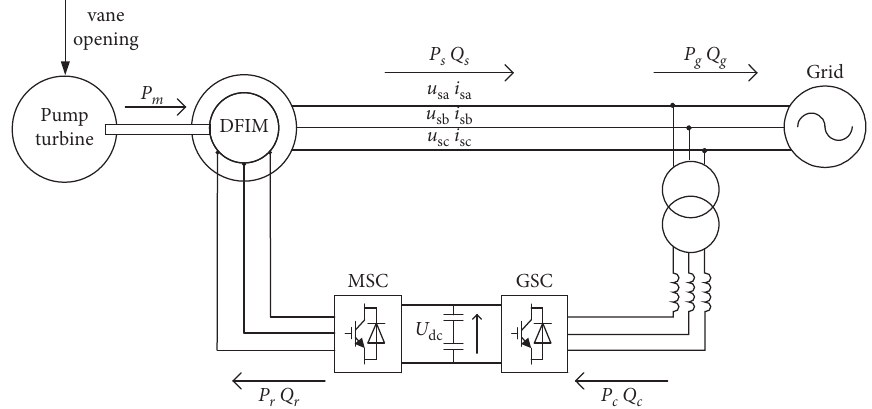
Figure 1: Structure diagram of the DFVSPS